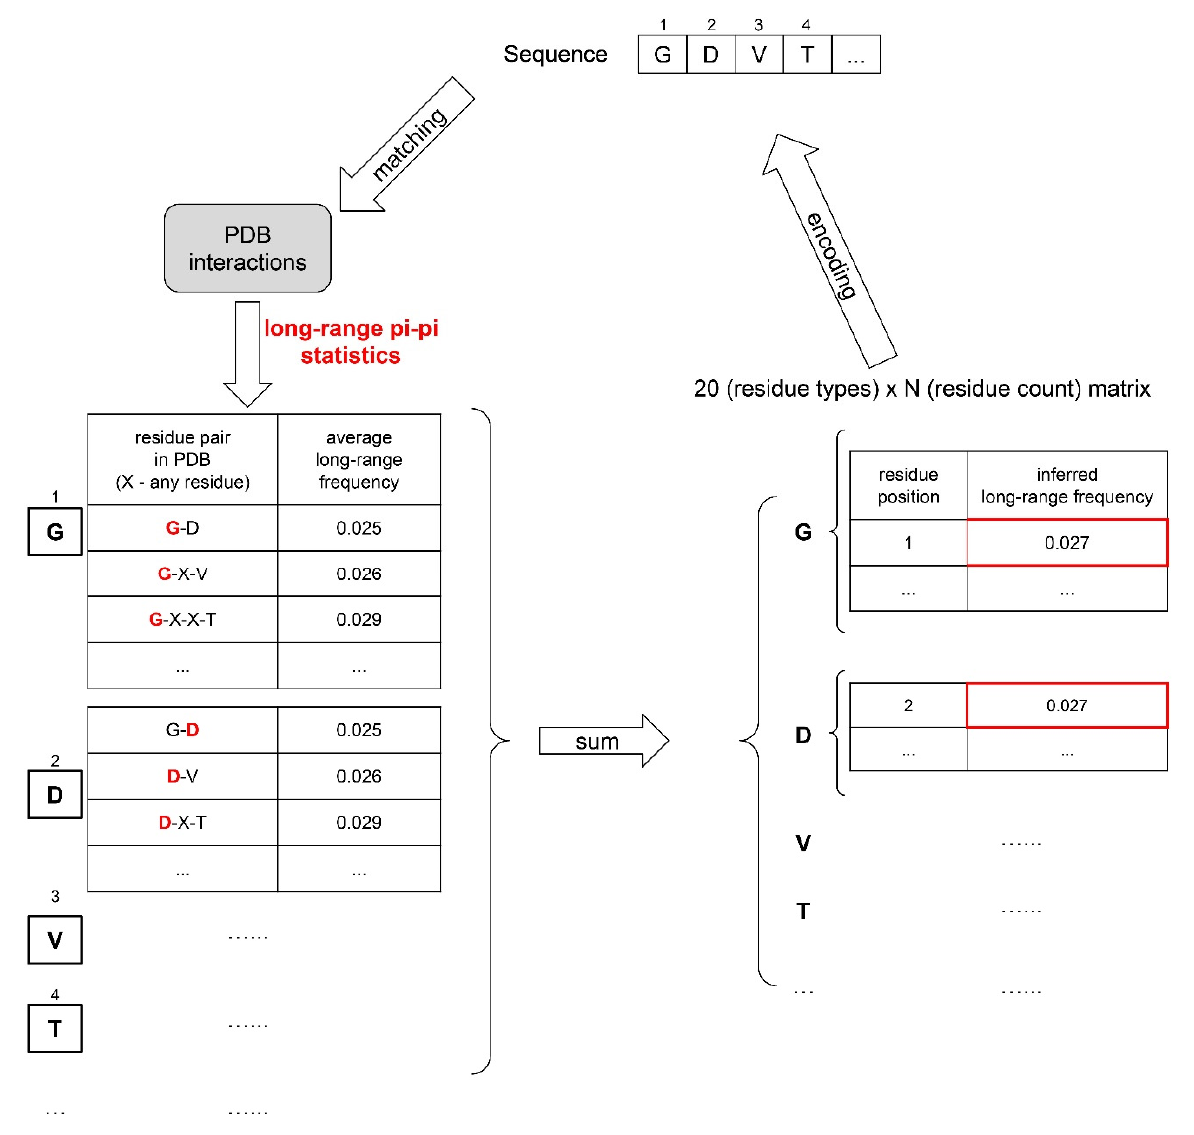
Figure 2. Physical-interaction- and structure-based feature extraction. An example is given of the feature representation of sequences for the sequence “GDVT” converted to the pi–pi (long-range) feature